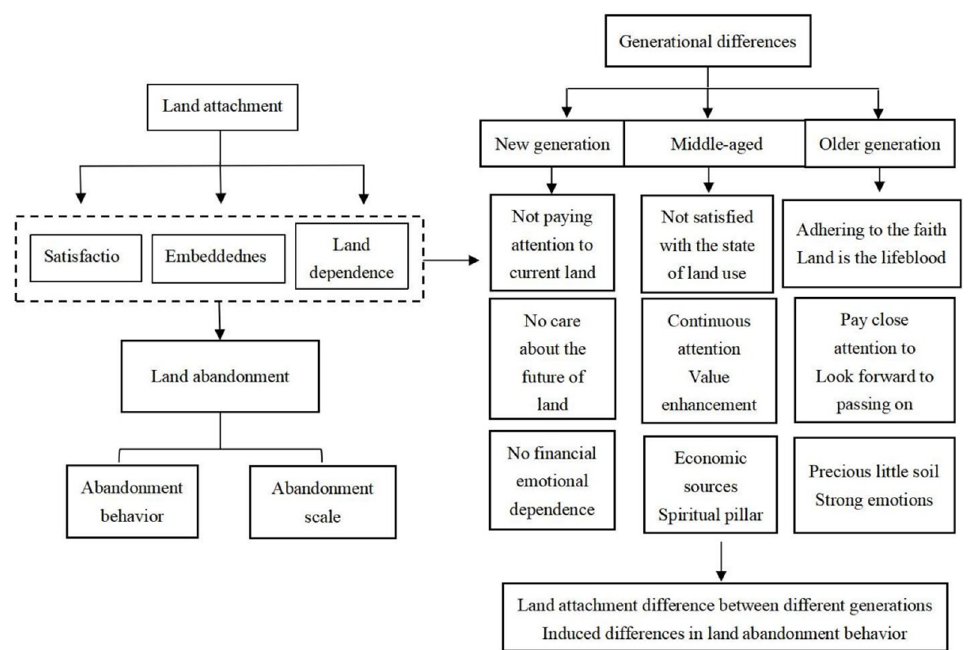
Figure 2. Conduction mechanism of intergenerational difference and land attachment on land abandonment.